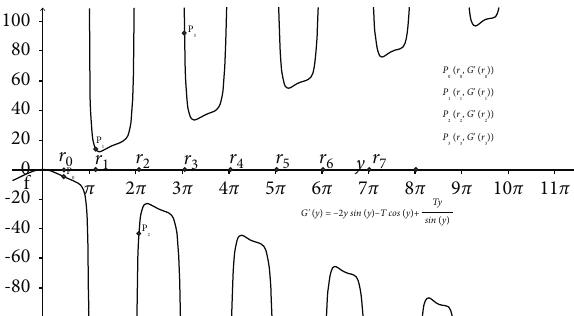
Figure 1: The graph of G ′ ( y ) and its value at the roots of G ( y ) , r in positive domain.